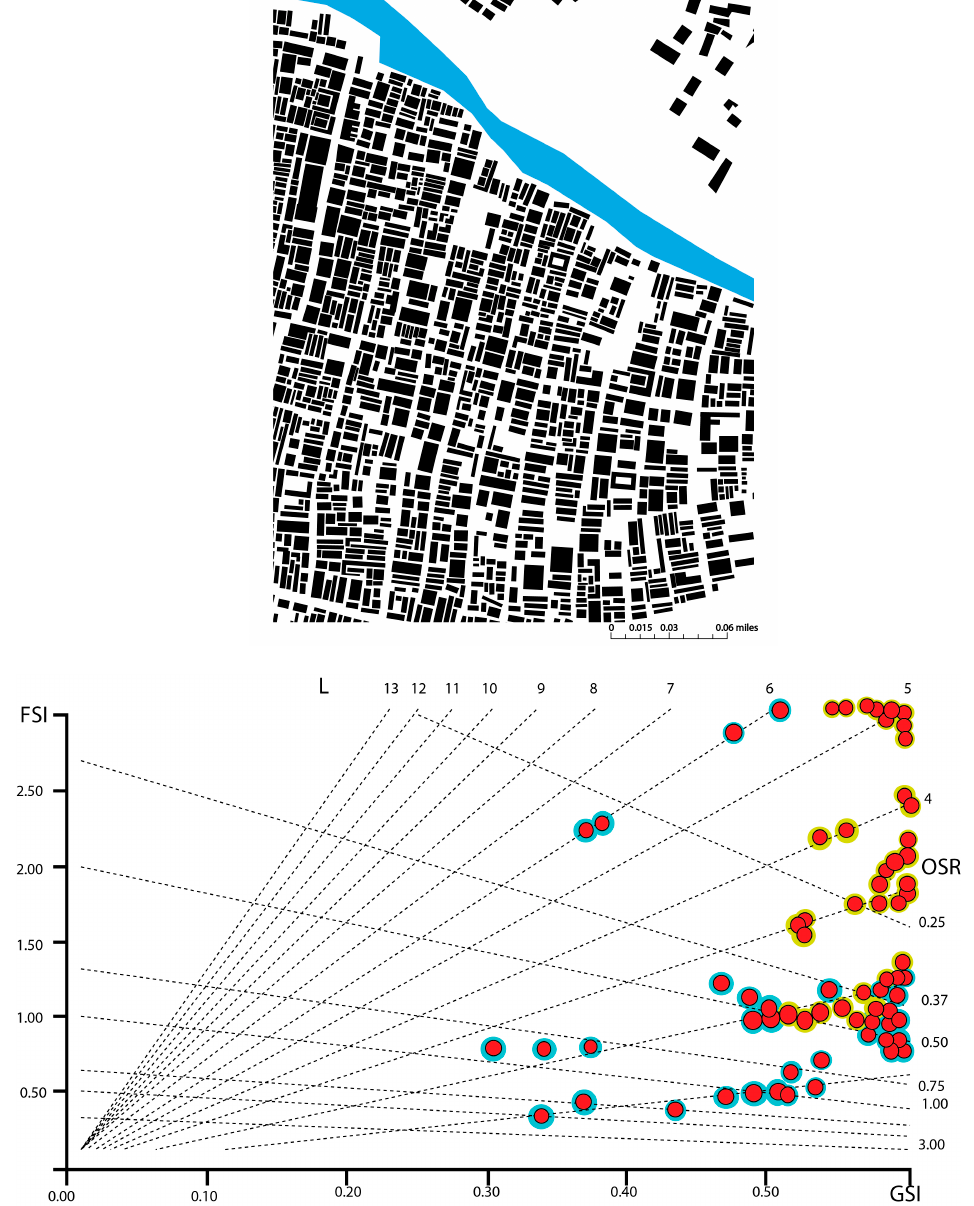
Figure 5. Results of Spacematrix analysis for an area in Keraniganj as an example.